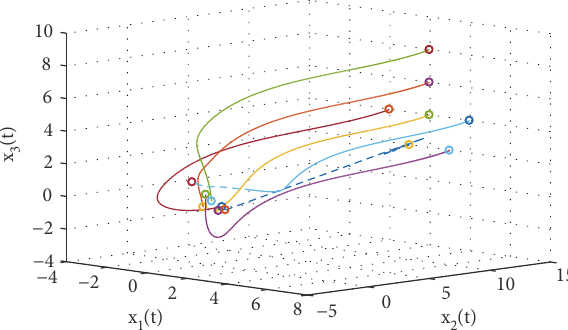
Figure 3: The trajectories of all agents with nonlinear dynamics between their initial formation and expected formation.